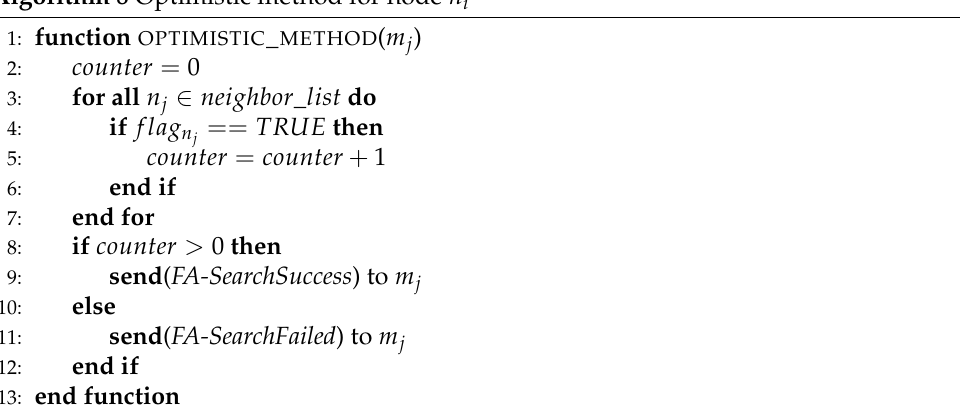
Algorithm 8 Optimistic method for node n i